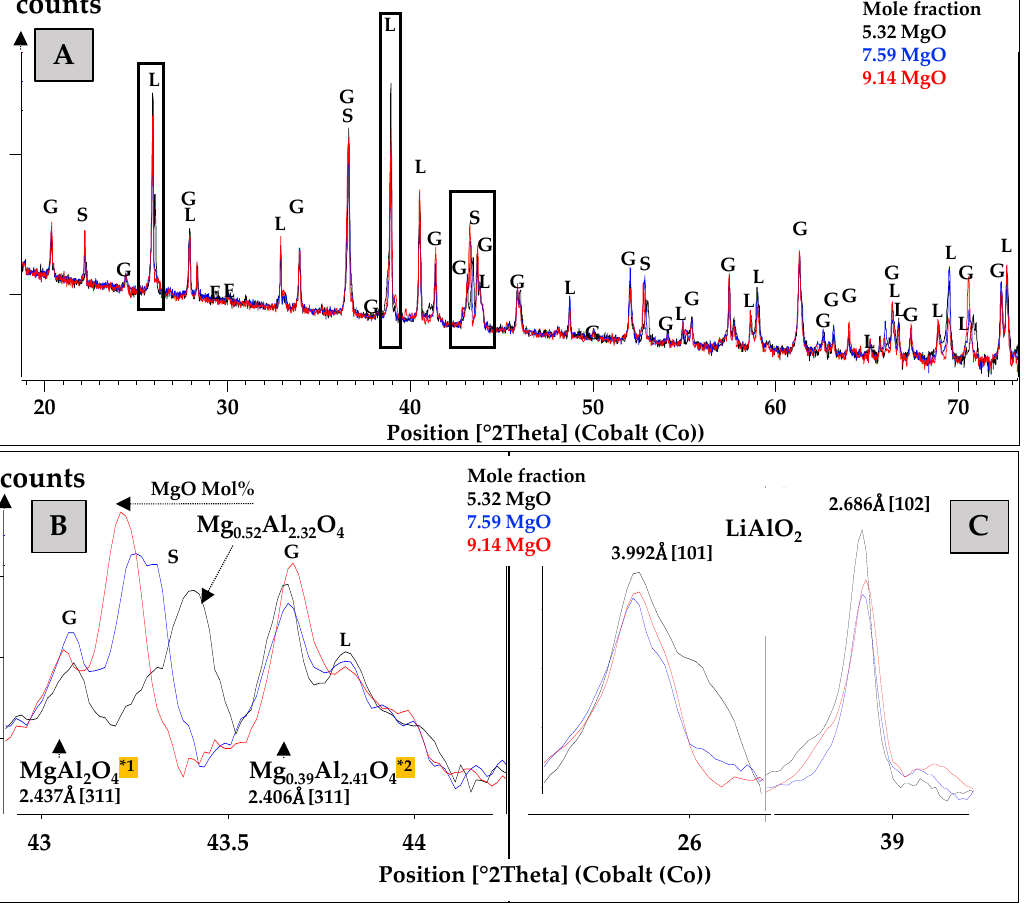
Figure 2. ( A ) PXRD of the solidified melt. G, gehlenite; S, spinel; L, LiAlO 2 ; E, eucryptite. ( B ) Enlarged section of the main spinel peak, * 1,: position of the main peak of MgAl 2 O 4 from the ICCD-PDF2 No. 00-021-1152; * 2, position of the main peak of an Al-rich spinel from the ICCD-PDF2 No. 00-048-0528, peaks; Mg 0.52 Al 2.32 O 4 , average composition of a spinel grain of the melt experiment with 5.32 Mol% Mg, determined with EPMA (see Section 4.2). ( C ) Enlarged sections of the first two main LiAlO 2 peaks.